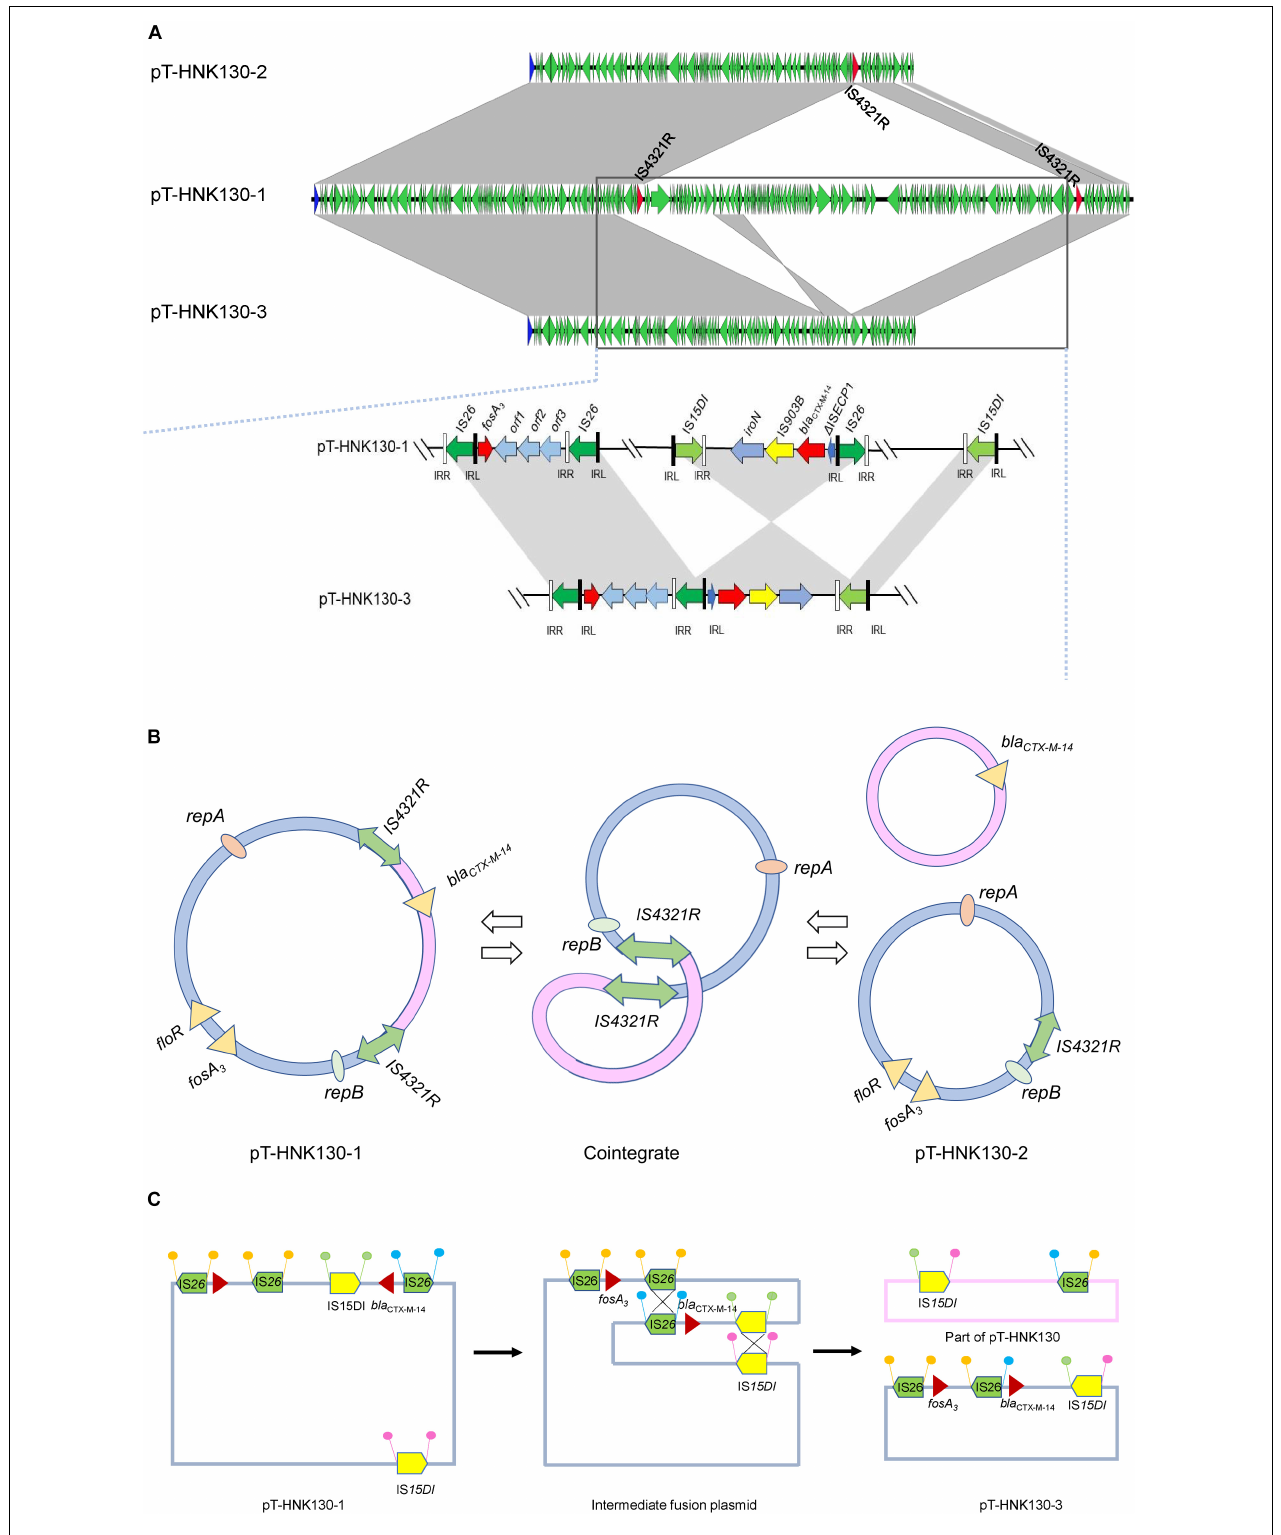
FIGURE 4 | (A) Complete sequence linear comparison of pT-HNK130-1, pT-HNK130-2, and pT-HNK130-3; (B) possible mechanism of pT-HNK130-2 formation; (C) possible mechanism of pT-HNK130-3 formation. Boxed arrows represent the position and transcriptional direction of ORFs. Regions of > 99% identity are marked by gray